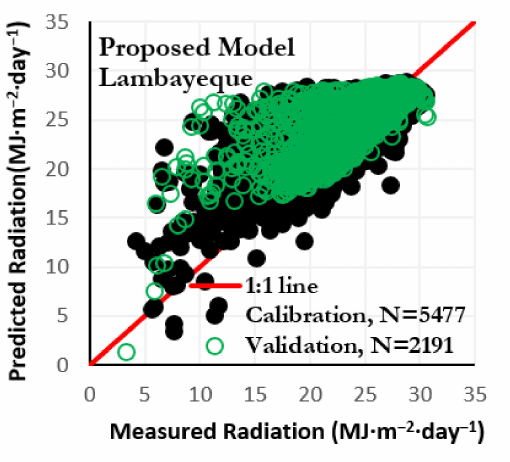
Figure 8. Solar radiation estimated by proposed model at Lambayeque station versus measured values in calibration and validation